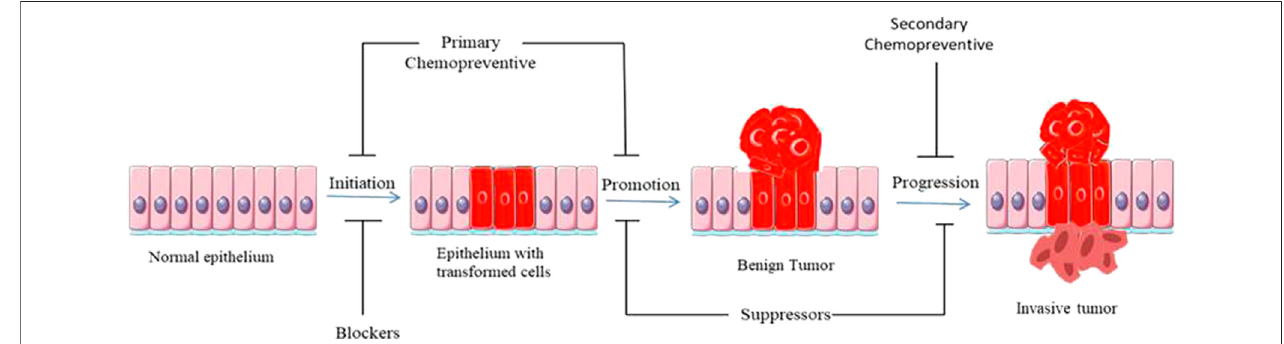
FIGURE 2 | Diagrammatic representation of sequential progression of cancer, with special reference to the stages at which different classes of chemopreventives act.